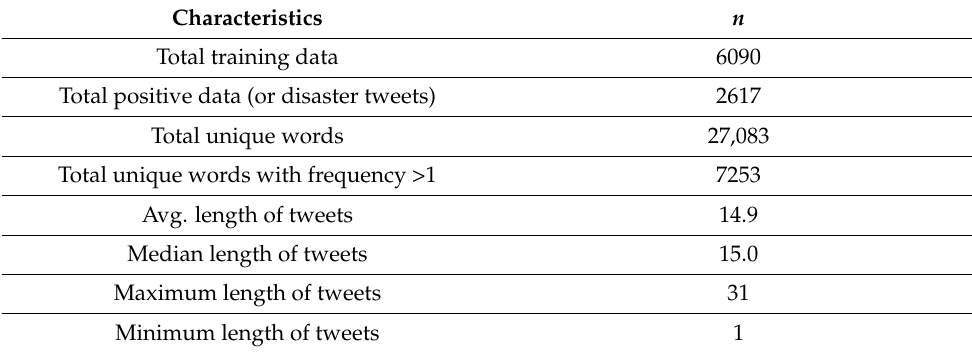
Table 4. Descriptive statistics for 80% training